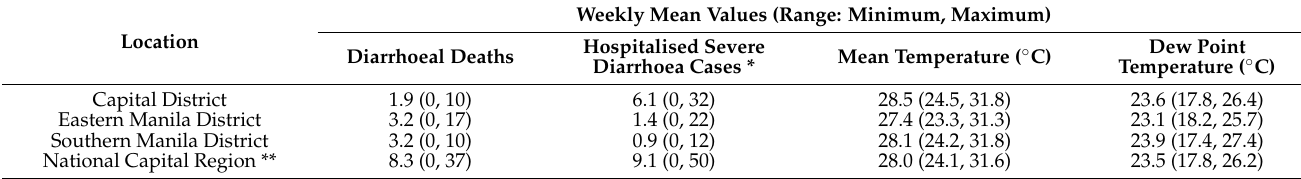
Weekly Mean Values (Range: Minimum, Maximum)